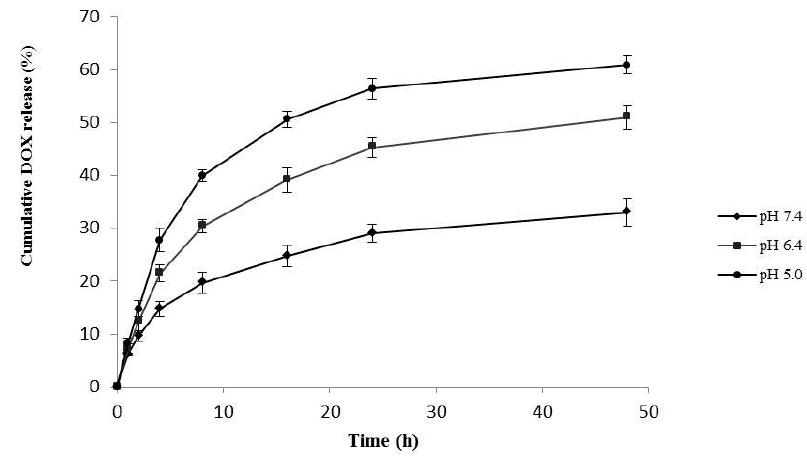
Figure 5. Release behavior of DOX from HA–GA/HA–His micelles at different pH values in vitro.